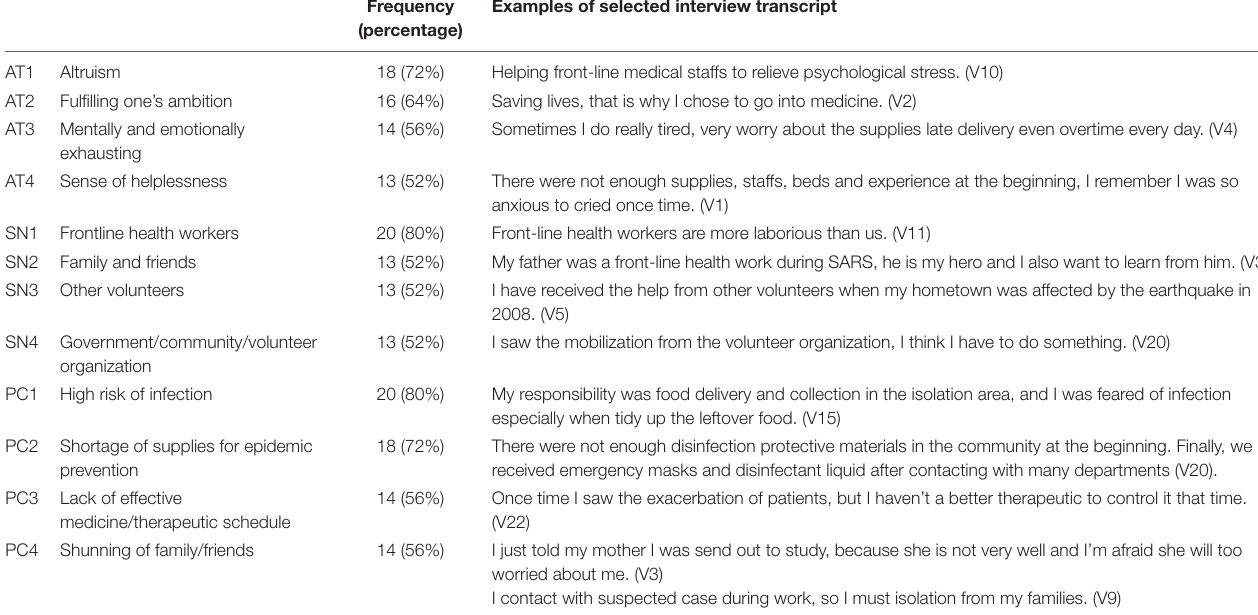
TABLE 2 | The results of study 1, antecedent factors of TPB.